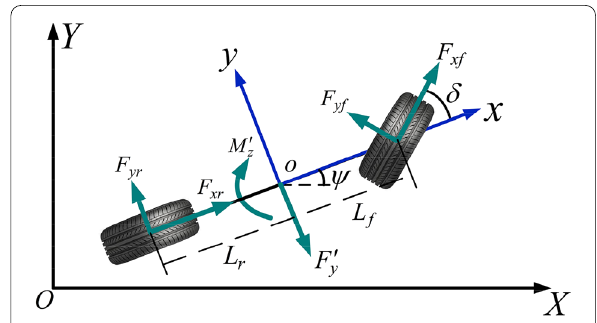
Figure 2 The single-track vehicle dynamics model in multiple coordinate